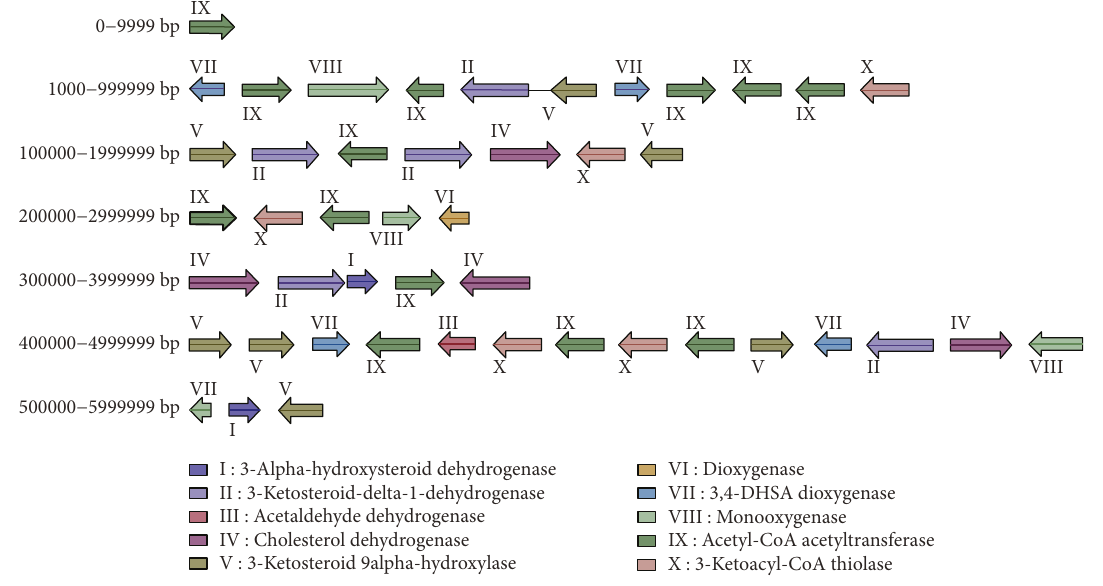
Figure 5: Distribution of estradiol-degrading enzymes in Rhodococcus DSSKP-R-001.